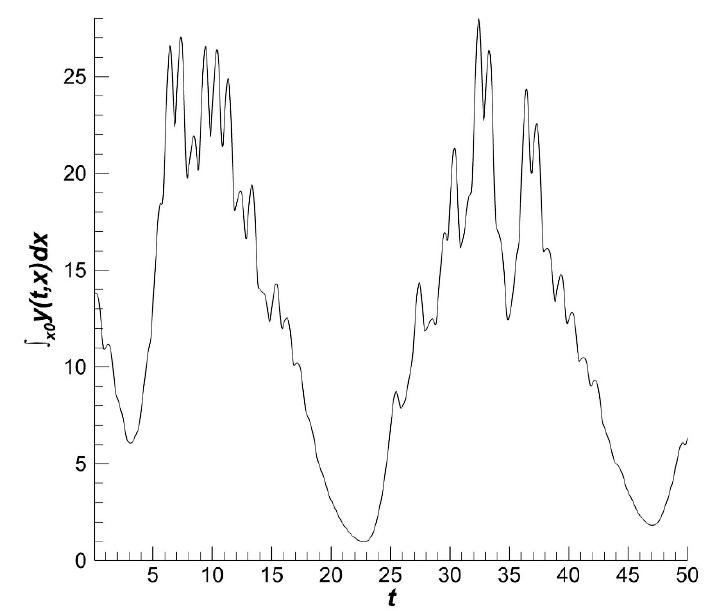
(cid:82) 1 y ( t , x ) dx . Figure 6. The dynamics of the fishery part of the population x 0 (cid:3051) (cid:3116) . (cid:3051) (cid:3116)